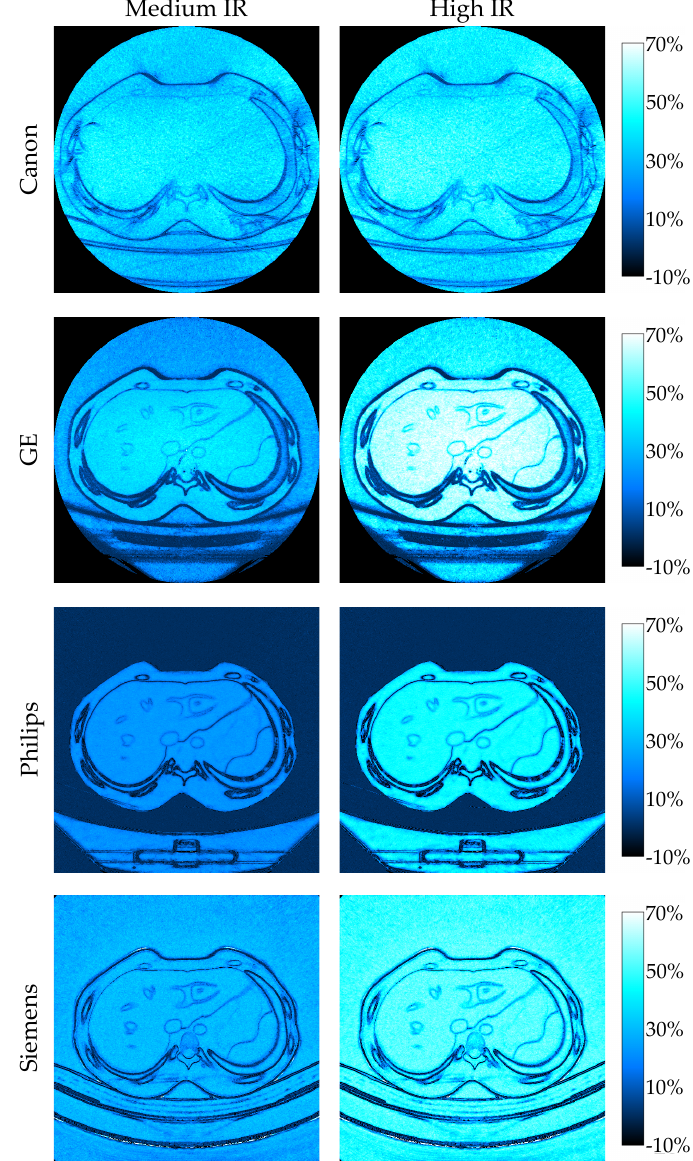
Figure A1. Noise reduction maps created by calculating the pixelwise relative noise reduction between the noise maps of each IR level compared to FBP for all vendors. A lighter color indicates a larger amount of noise reduced in the given pixel compared to FBP. The darkest blue and black colors, representing values smaller than 0%, indicates a noise increase compared to